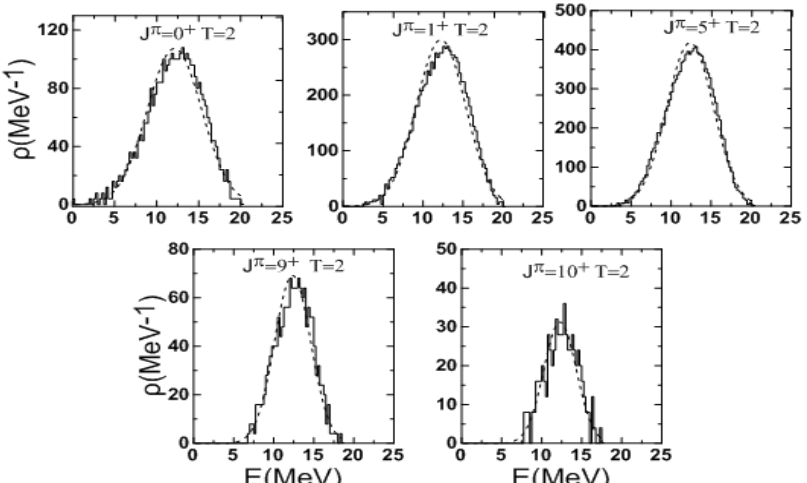
Fig. 1: The level density (histograms) is compared with the Gaussian fit (dash curves) in 68 Ge for J π = (0 + ,1 + , 5 + , 9 + , and 10 + )